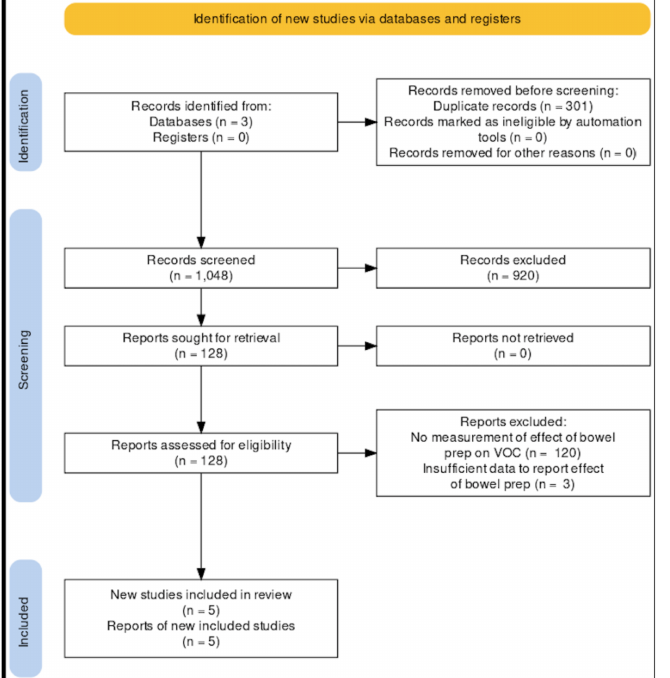
Figure 2. PRISMA flow diagram showing the search and selection process of the reviewed